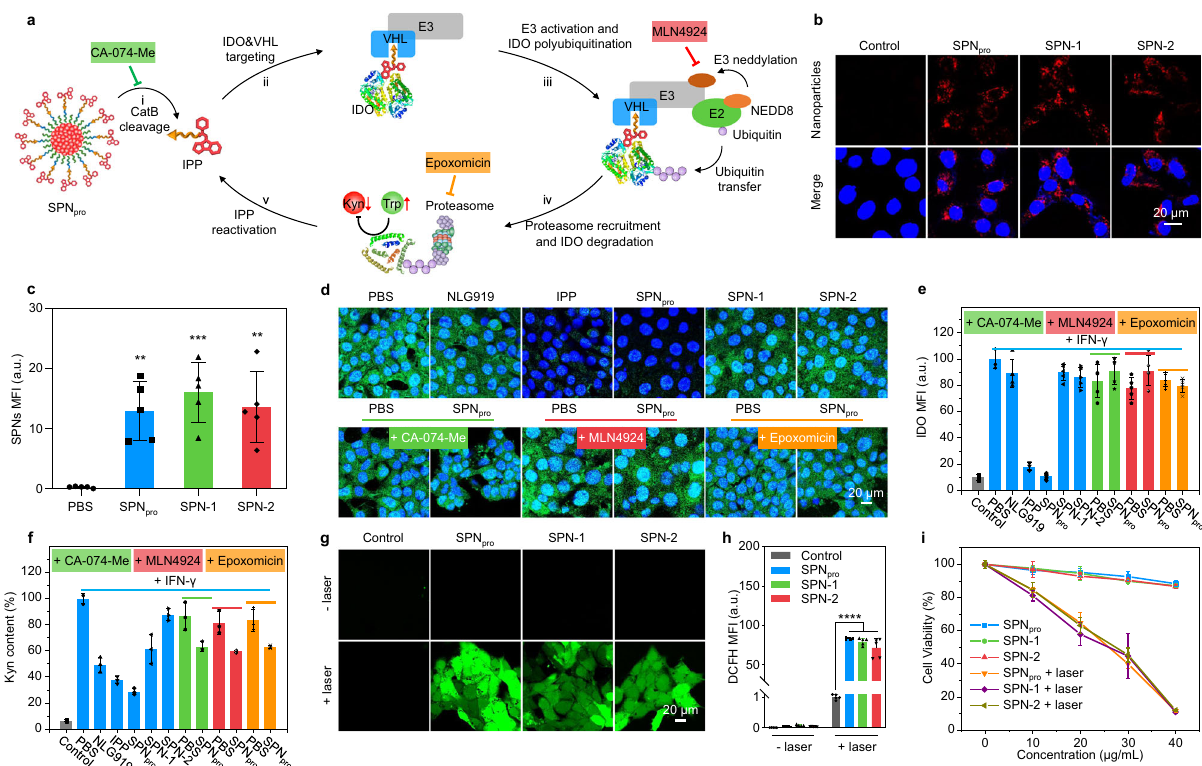
Fig. 3 In vitro SPN pro -mediated activatable photo-immunometabolic therapy. a Proposed mechanism for CatB-speci fi c activation of PROTAC-mediated IDO degradation from SPN pro . Confocal fl uorescence images ( b ) and MFI ( c ) of 4T1 cancer cells after 24 h incubation with SPN pro , SPN-1, and SPN-2 ([PCB] = 20 μ g/mL) ( n = 3). Control versus SPN pro : p = 0.0025; Control versus SPN-1: p = 0.0003; Control versus SPN-2: p = 0.0016. Blue fl uorescence indicated the cell nucleus stained with 4 ’ ,6-diamidino-2-phenylindole (DAPI), and red fl uorescence showed the signals from the PCB core. Confocal fl uorescence images ( d ) and MFI ( e ) of IFN- γ -stimulated 4T1 cells treated with various inhibitors (CA-074-Me, the CatB inhibitor; MLN4924, the neddylation inhibitor; epoxomicin, the proteasome inhibitor) after 12 h incubation with SPN pro , SPN-1, or SPN-2 ([PCB] = 20 μ g/mL), followed by staining with green fl uorescent anti-IDO antibody ( n = 3). The cell nucleus was stained with DAPI (blue). f Relative Kyn content in the cell culture medium after 12 h incubation with SPN pro , SPN-1, or SPN-2 ([PCB] = 20 μ g/mL) by HPLC assay ( n = 3). Confocal fl uorescence images ( g ) and MFI ( h ) of 4T1 cells after 12 h incubation with SPN pro , SPN-1, or SPN-2 ([PCB] = 20 μ g/mL), followed by staining with H 2 DCFDA with or without NIR photoirradiation (0.3 W/cm 2 at 808 nm) for 6 min ( n = 3). Control + laser versus SPN pro + laser: p < 0.0001; Control + laser versus SPN-1 laser: p < 0.0001; Control + laser versus SPN-2 + laser: p < 0.0001. Green fl uorescence indicated the signals from DCF. i Relative cell viabilities of 4T1 cells after 12 h incubation with SPN pro ,